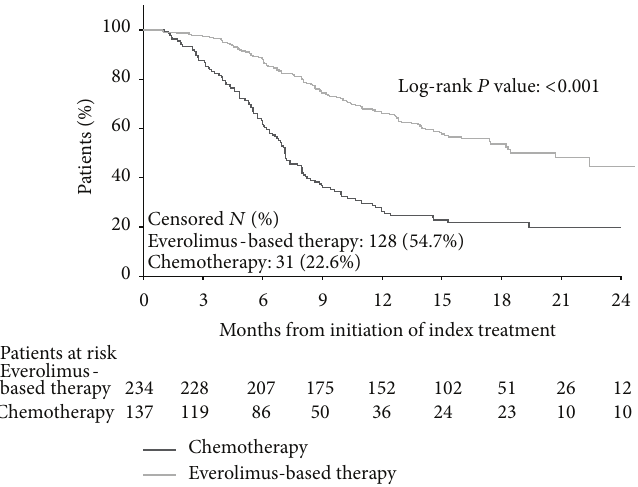
Figure 1: Comparison of time on treatment between everolimus-based therapy and